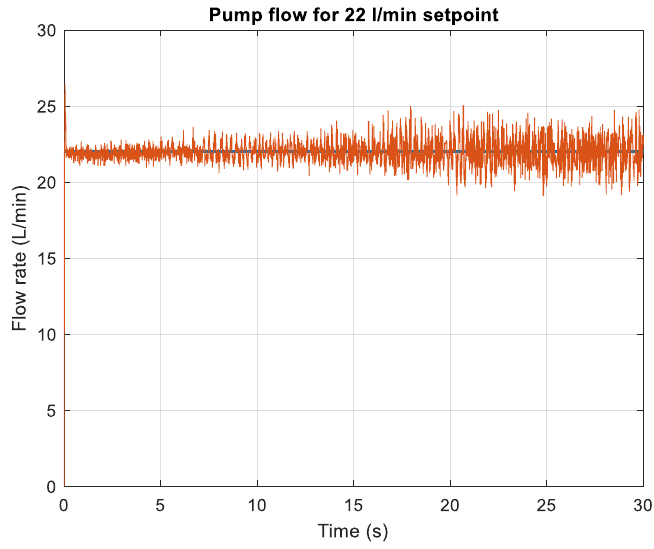
Figure 22. Pump flow rate for 22 L/min setpoints.